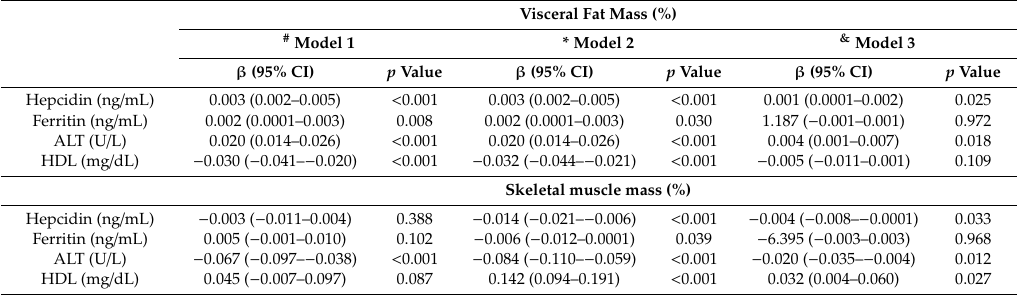
Table 3. Associations of selected response variables with the visceral fat mass and skeletal muscle mass ( N =